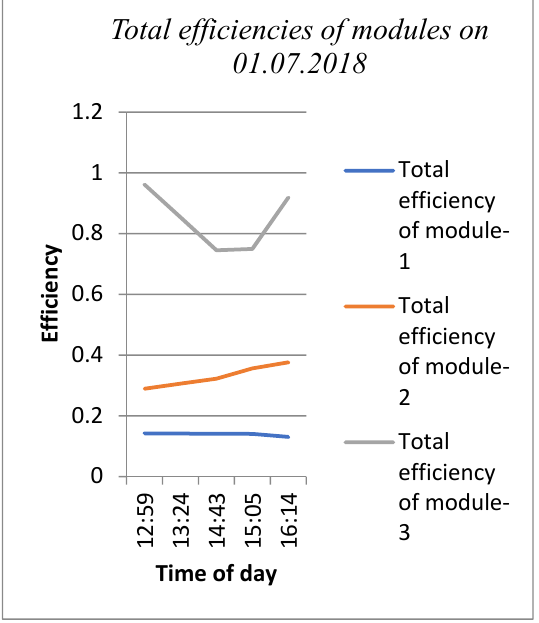
Figure 19. Total efficiencies of modules on 01.07.2018.